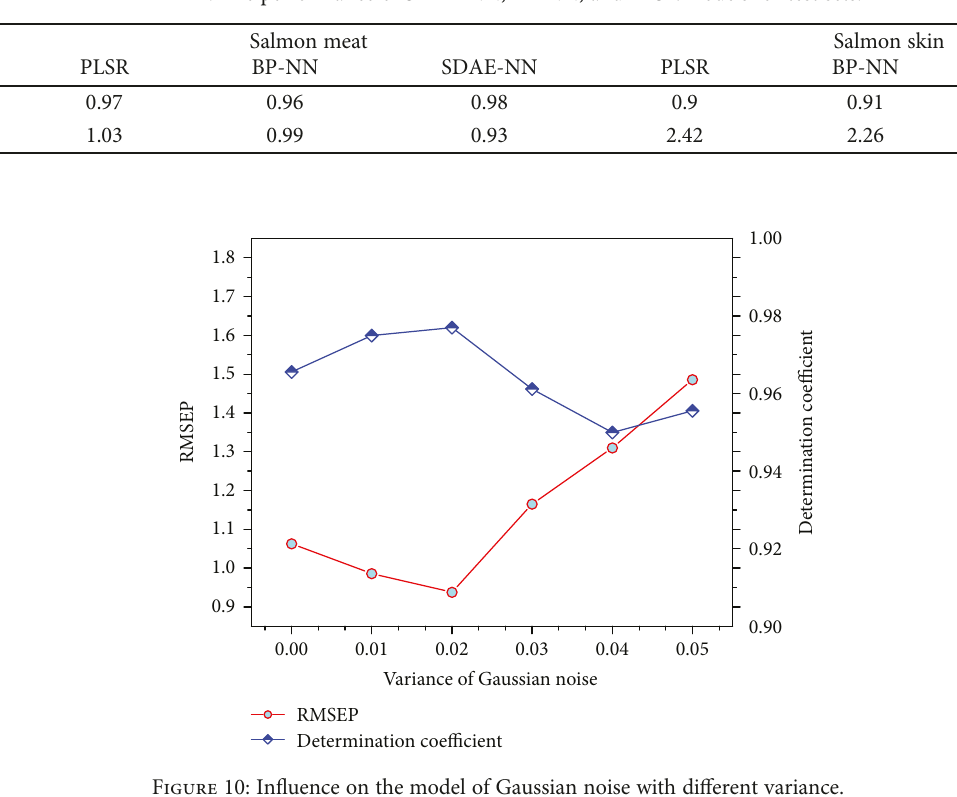
Table 1: The performance of SDAE-NN, BP-NN, and PLSR models for test sets.